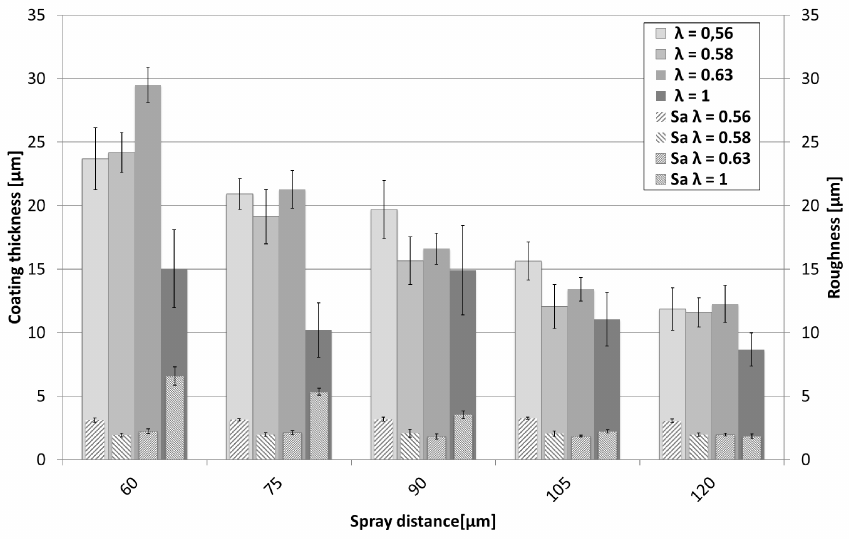
Figure 19. Comparison of coating thickness and roughness values of Ag coatings sprayed at different spray distances and λ values.